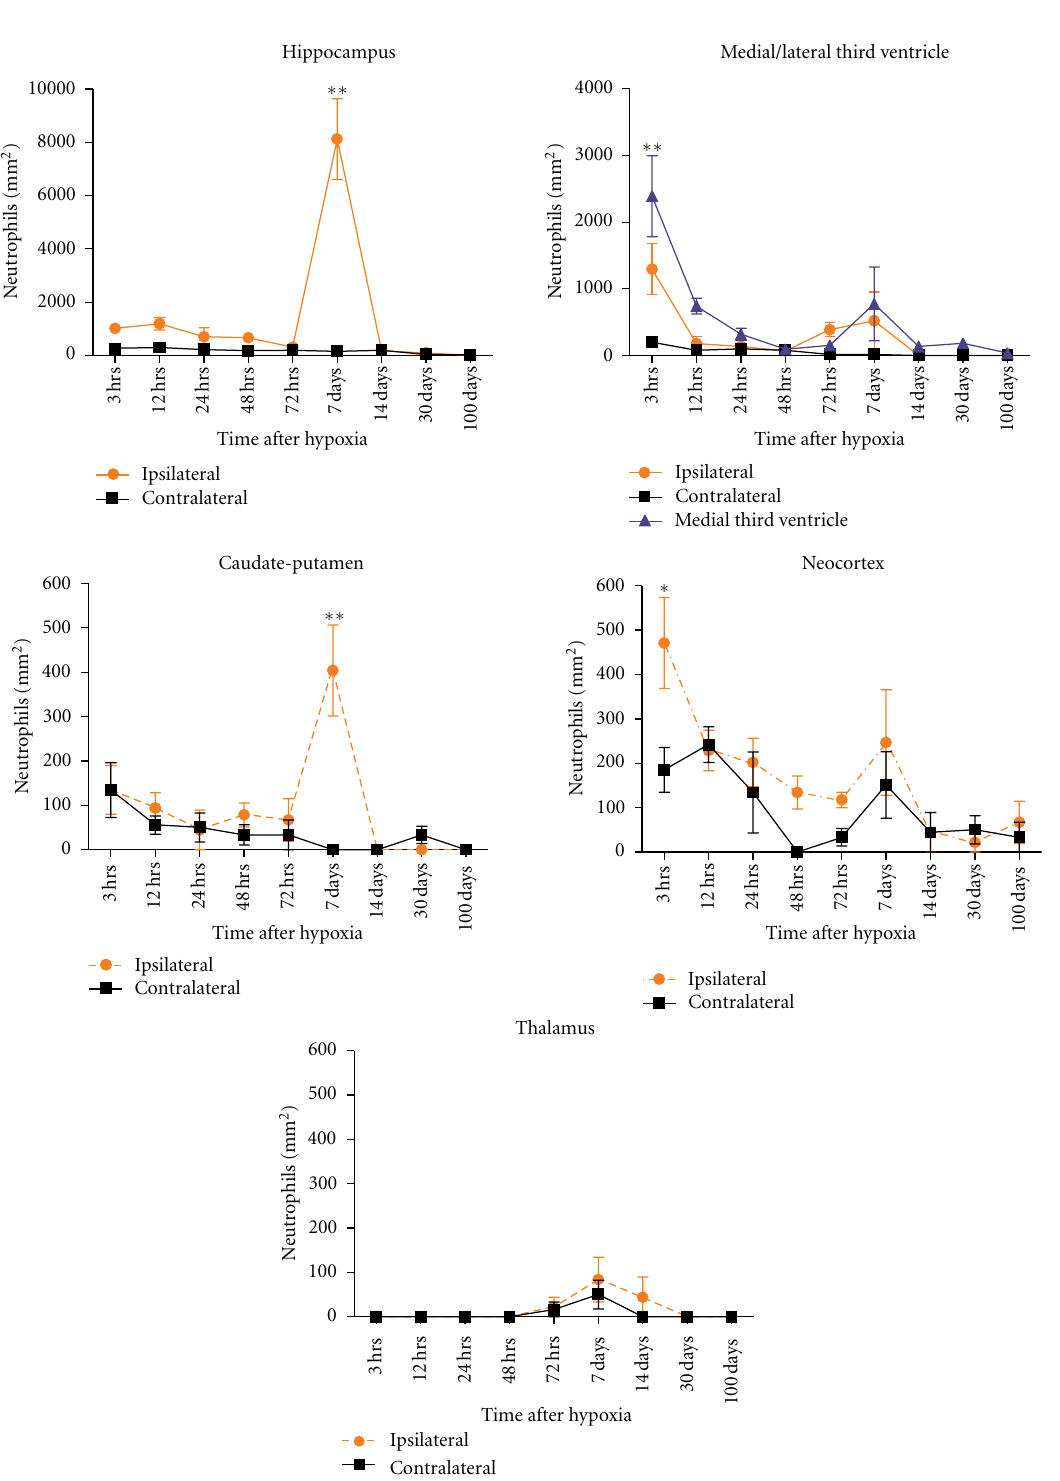
Figure 13: Neutrophils quantification is done using image J software (NIH) and is evaluated at 3–72 hours and 7–100 days. The regions analysed were the hippocampus, medial/lateral third ventricle, caudate-putamen, neocortex, and thalamus. The quantity in the ipsilateral side is compared to the contralateral hemisphere. Significant changes are observed in the ipsilateral side of the hippocampus and caudate- putamen at 7 days after hypoxia while a decrease in number is observed after 3 hours in the ventricles and neocortex. There is no change in the thalamus. All values are represented as mean ± S.E.M and are corrected using Abercrombie correction method. Two-way ANOVA with Bonferroni post-hoc analysis is used to compare ipsilateral versus contralateral hemisphere at all time points and ∗ P < 0 . 01, ∗∗ P < 0 . 001 was considered